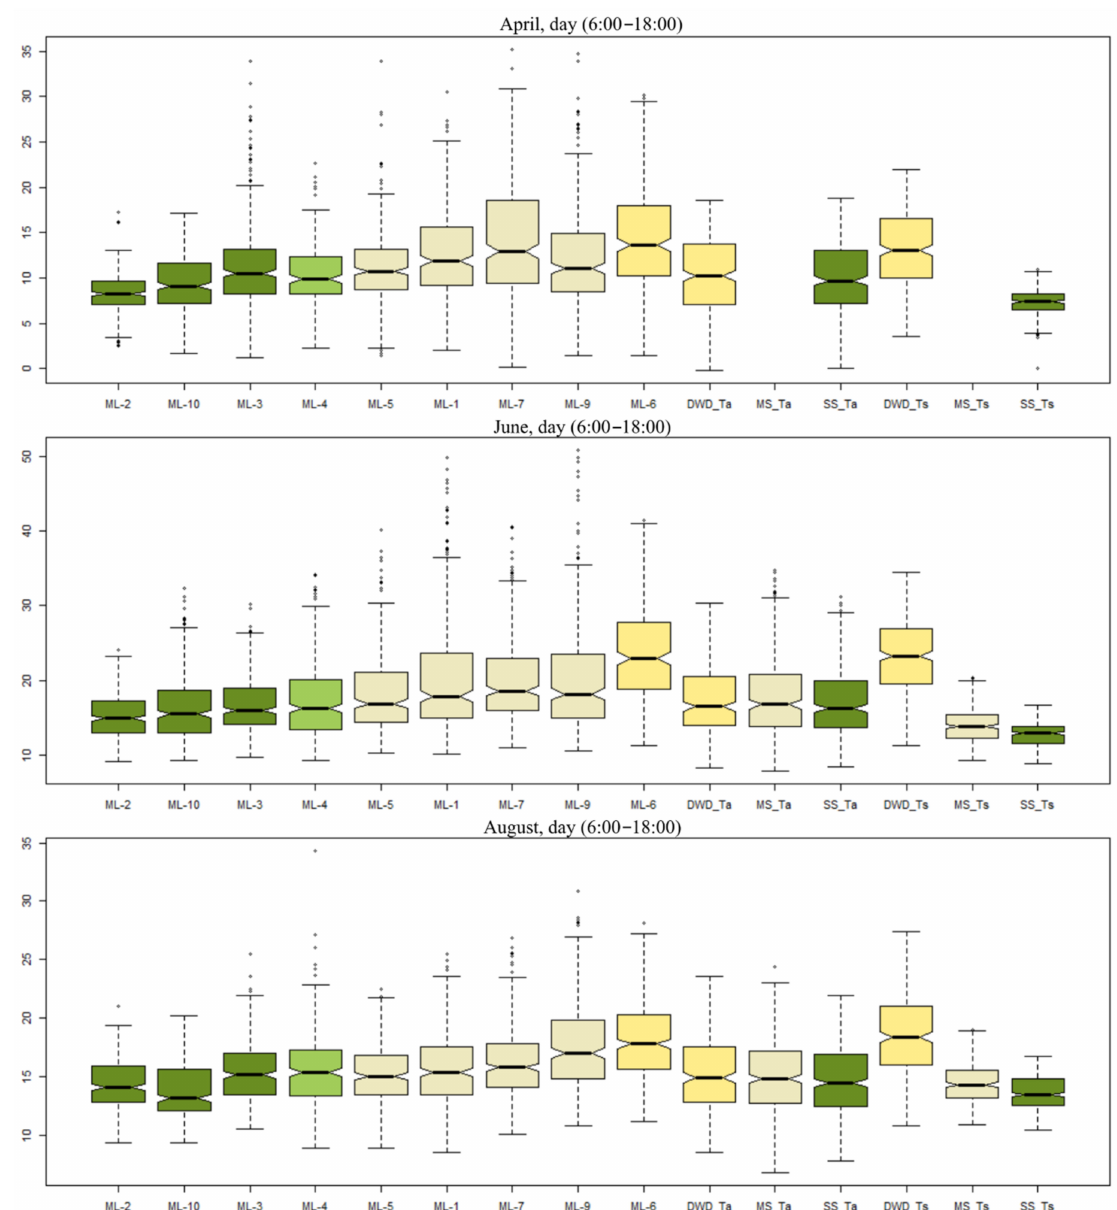
Figure 7. Overview of the data distribution at daytime in April, June and August 2014. Again, the colors imply the grade of shading of the loggers and stations (dark green = very shaded/moss, yellow = open land/grass, beige = temporal shading/grass (ML-9 = moss), light green = temporal shading/leaf litter). The ordinate depicts the temperature ( ◦ C), please note the different